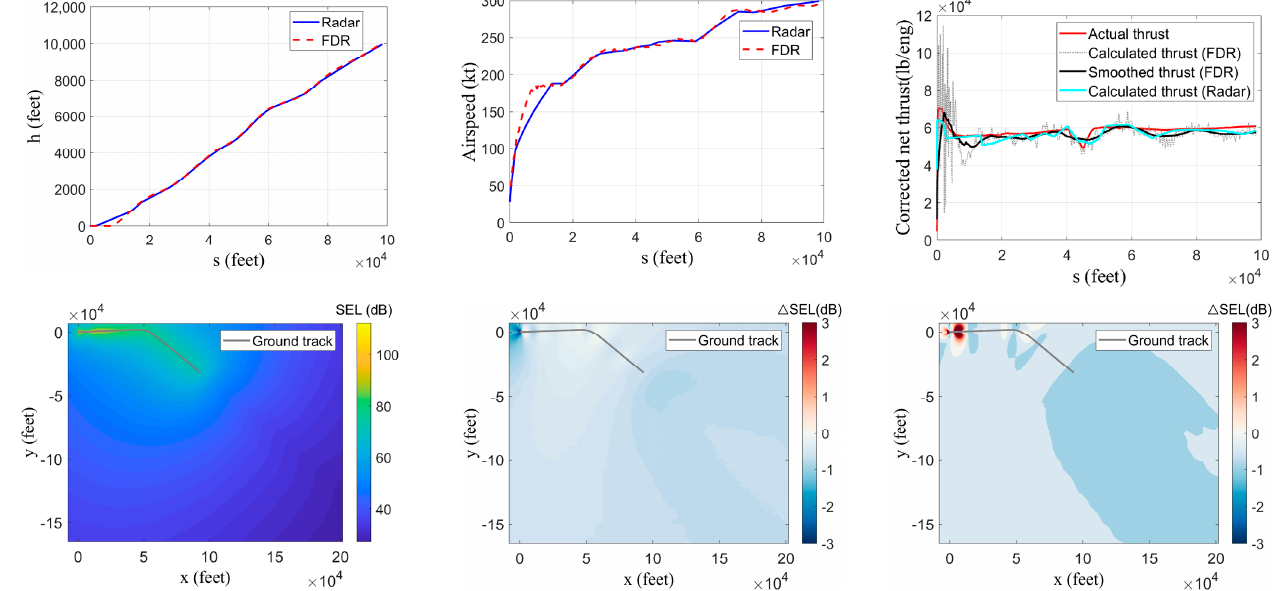
Figure 26. B777 aircraft departing from HKIA (flight BD2). Top: Comparison between the flight profile (left), airspeed (center), calculated and actual thrust (right) inferred from the FDR and radar data. Bottom: Noise contour map, as obtained using FDR data and actual thrust (left). Error entailed by an approximation of the thrust (center: smooth calculated thrust) plus the trajectory estimation (right: radar data, calculated thrust).